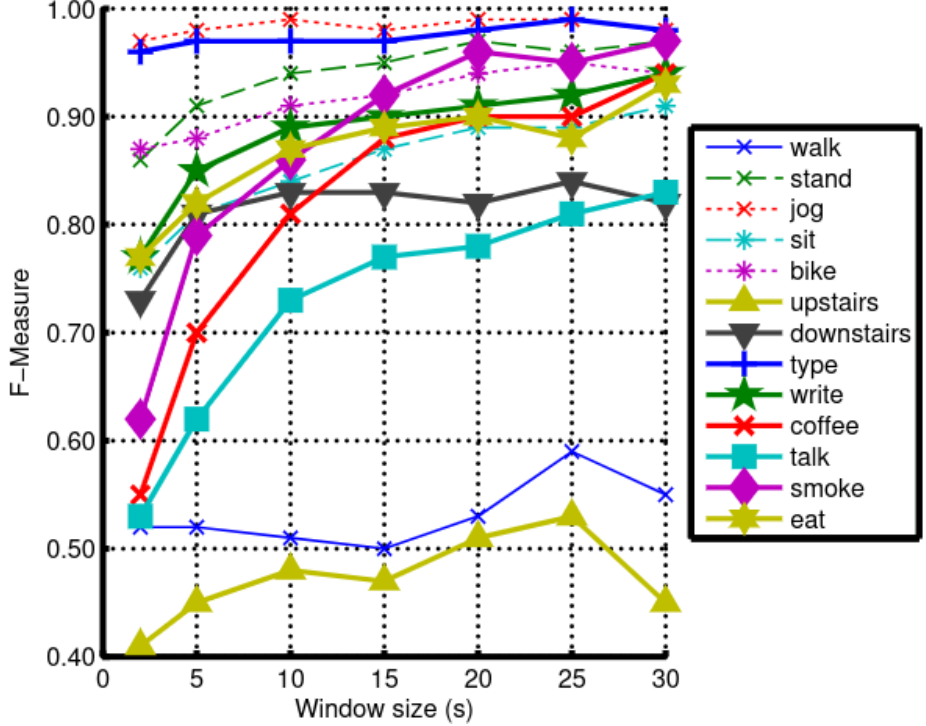
Figure 5. Effect of window size (in seconds) on the recognition performances (F-measure) of an activity recognition model trained on various daily activities such as walk, stand, and jog. Depending on the activity being monitored, the effect of the window size on the final model’s performances varies to a large extent. From